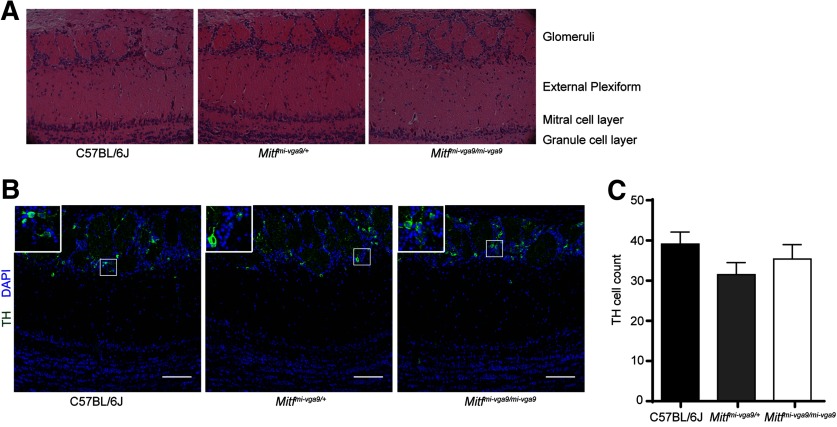
Mitfmi-vga9/mi-vga9 mice have normal OBs. A, Representative images of the H&E histologic analysis of coronal sections of the medial OBs of the indicated genotypes. B, Immunofluorescent staining of TH showing the localization of TH in the glomeruli of the indicated genotypes. C, Cell count of TH+ cells of the OB of wild-type, Mitfmi-vga9/+, and Mitfmi-vga9/mi-vga9 mice. N = 6 per genotype. The values on the graphs are mean ± SEM DAPI nuclear staining is shown in blue. Scale bar: 100 μm; p values were calculated using one-way ANOVA (C).